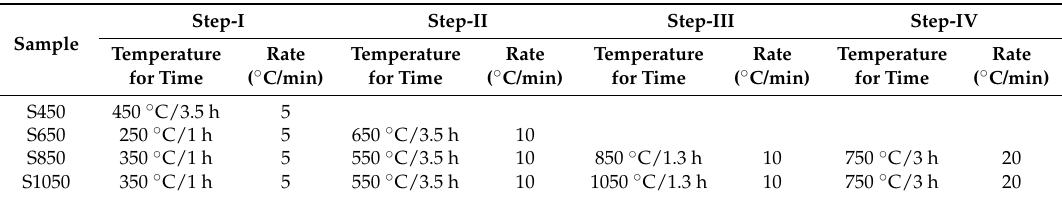
Table 1. Schematic sintering steps of samples S450, S650, S850, and S1050.